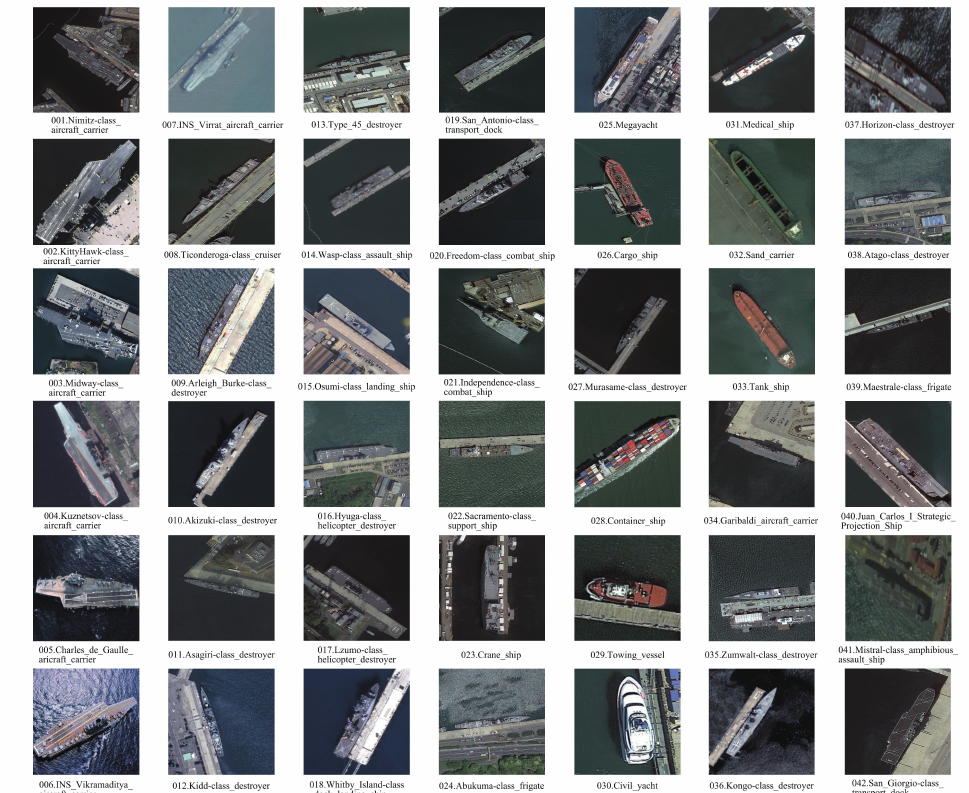
Figure 1. Typical images of all categories in FGSCR-42 dataset. Examples contain ships in the harbor and sea areas with various backgrounds, different angles, large spatial resolution and different levels of